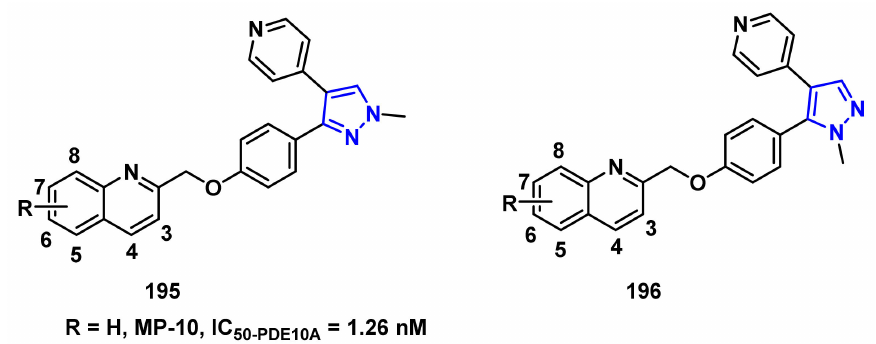
Figure 19. Chemical structures of pyrazole-containing PDE10A